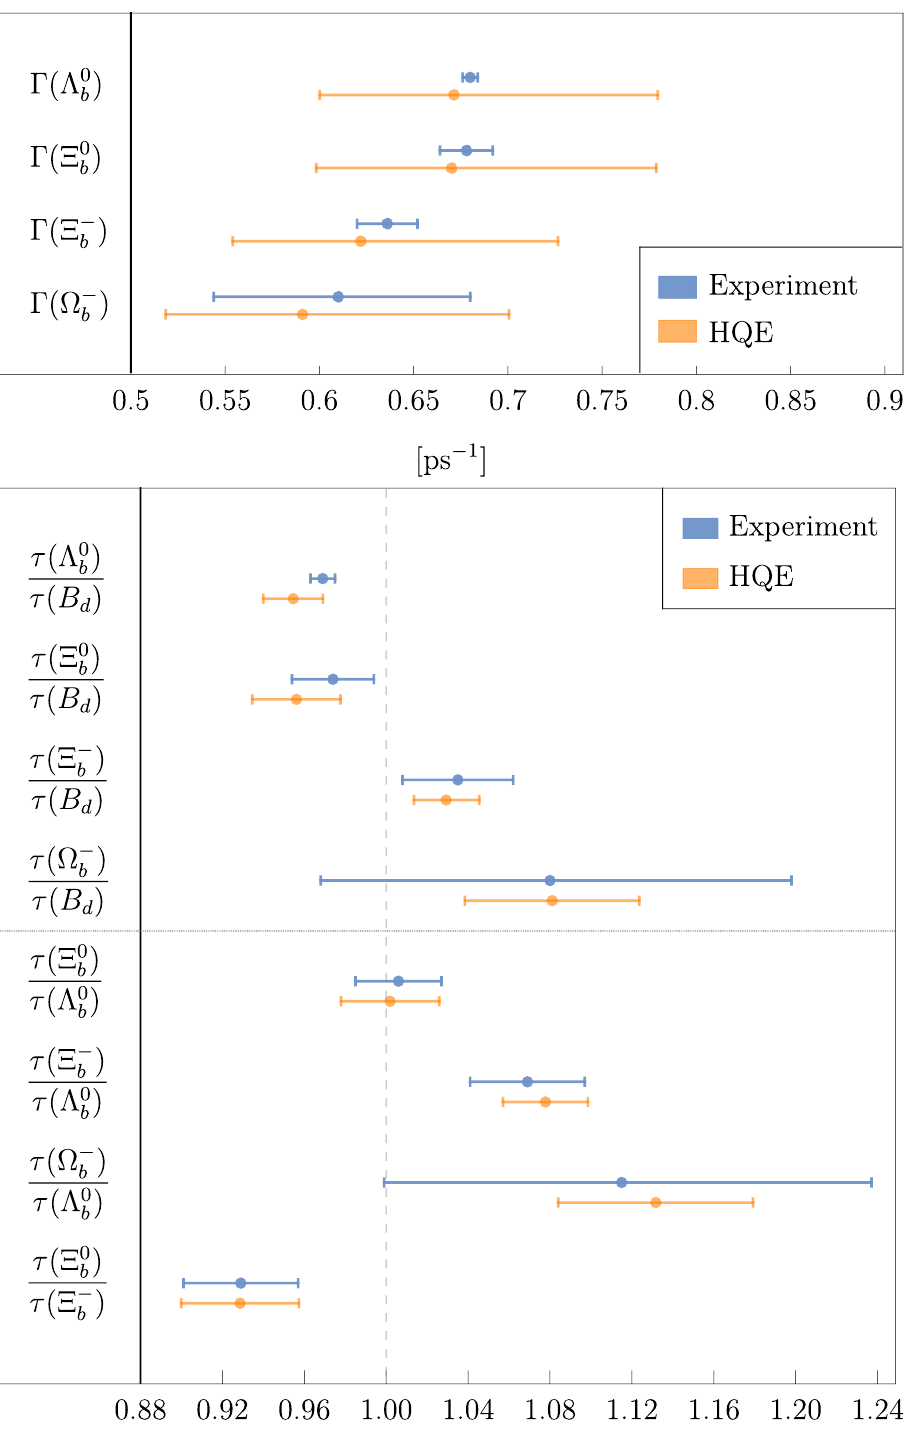
Figure 3 . Graphical representation of the results presented in table